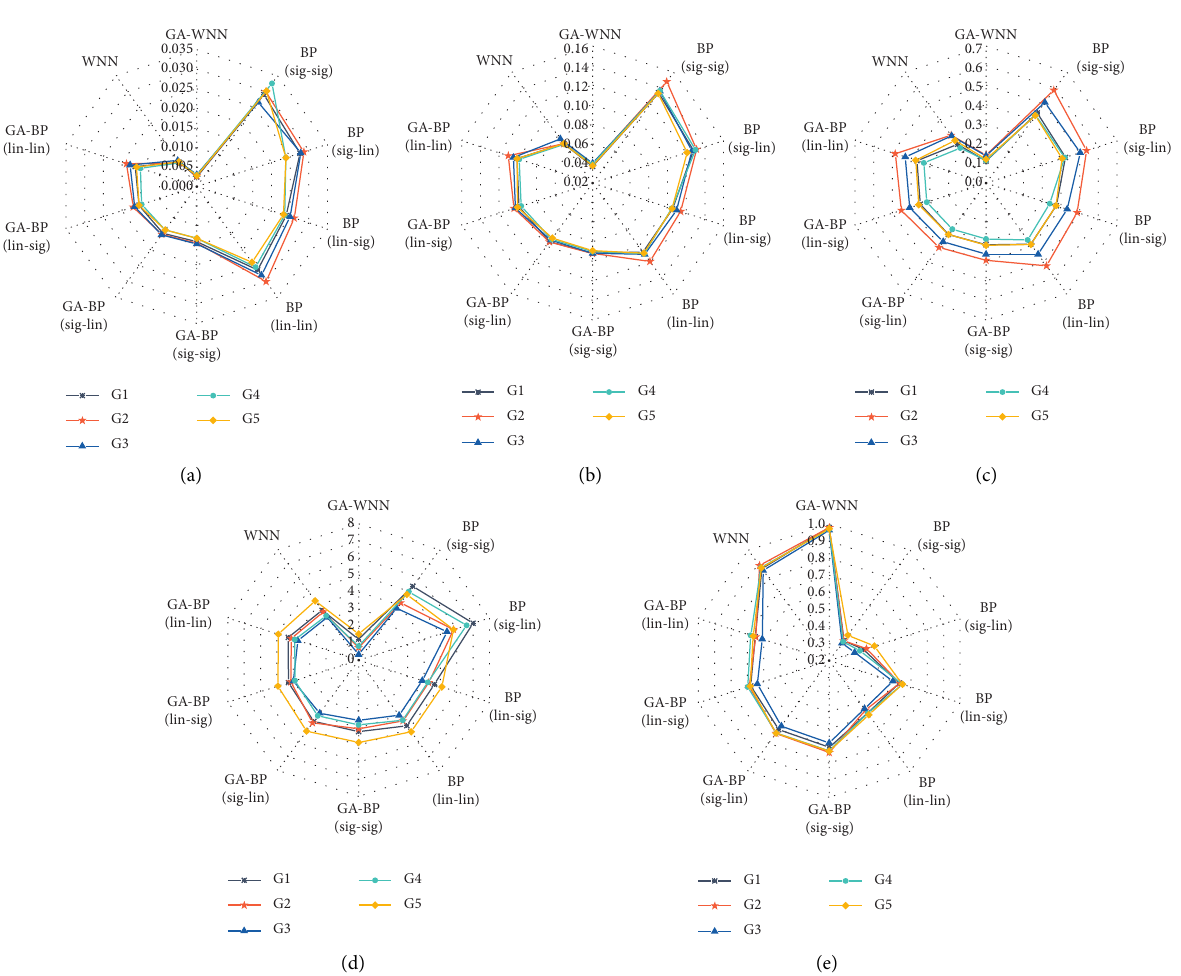
Figure 6: Different models performance using 5 groups of validation data in terms of (a) MSE, (b) MAE, (c) MAPE, (d) Max-APE, and (e)